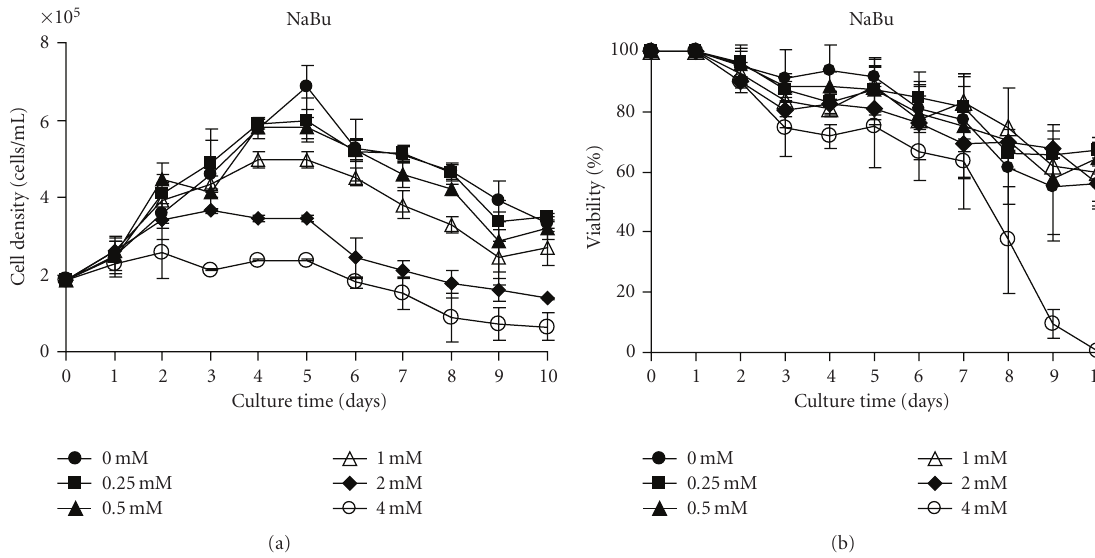
Figure 1: NaBu influence on cellular growth and viability of hPRL-secreting CHO cells. (a) Cellular growth and (b) cellular viability in a 10- day hPRL production period under di ff erent NaBu concentrations. The cell viability was determined by the trypan blue exclusion procedure, following trypsinization. Values are the mean of two independent determinations.